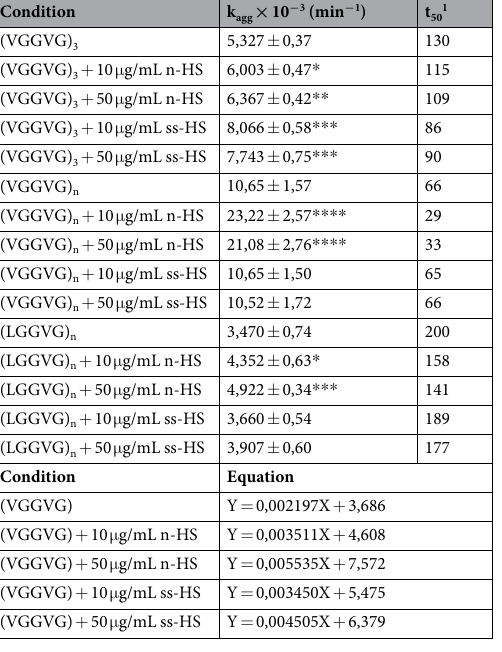
Table 1. Aggregation rate constants (k agg ) for elastin-like peptides (ELPs) in presence or in absence of natural (n-HS) or semisynthetic (ss-HS) heparan sulfates. The rate constants ± standard deviations were calculated through exponential curve fitting. For (VGGVG) ± heparan sulfates linear regression function is reported indicating insignificant fibrillation. t 50 ( = half-time is the amount of time expressed in minutes required to reach half of the maximum fluorescence intensity of the final fluorescence). * p < 0.05; ** p < 0.01; *** p < 0.001; **** p < 0.0001 ELP alone vs the same EPL +